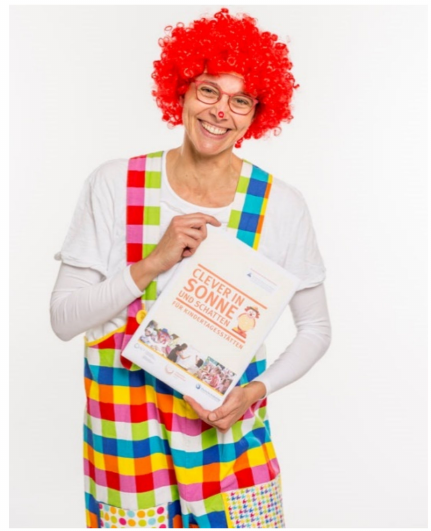
Figure 8. CLEVER project kit for mailing © NCT/UCC 2018.